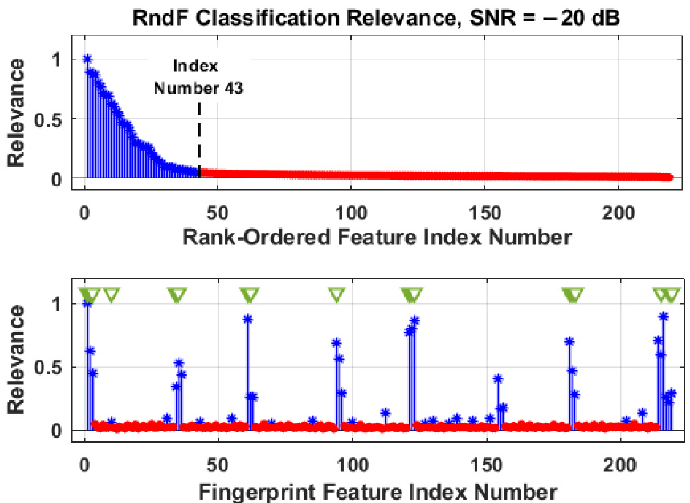
Figure 7. Stem plots illustrating DRA feature selection for RndF classification using the N FD = 219 full-dimensional feature set. The blue asterisk ( ∗ ) markers denote the most relevant N DRA,RndF = 43 features, the red dot ( • ) markers denote the least relevant 176-of-219 features, and the green triangle ( ▽ ) markers identify selected features shared in common with LVQ in Figure 8.